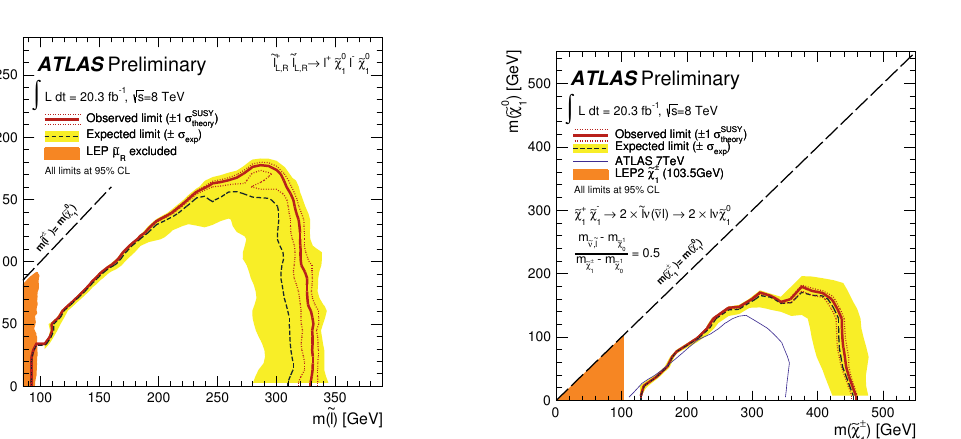
Figure 12: 95% CL exclusion limits for ˜ χ pair production in the simplified model with − m ˜ (cid:9) plane. ˜ χ 0 1 sleptons and sneutrinos with m ˜ m ) / 2. Chargino masses between 130 GeV and ˜ χ 0 1 450 GeV are excluded at 95% confidence level for a 20 GeV neutralino. [10]